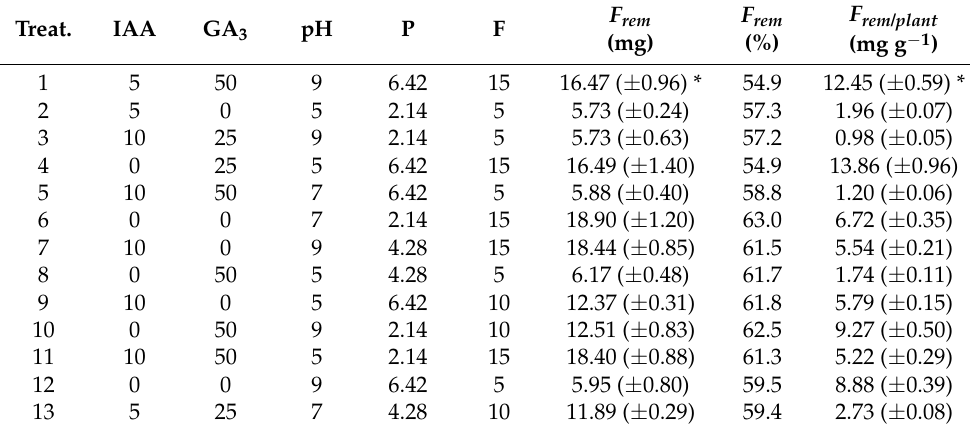
* Values in parenthesis represent standard deviation from three replicates.